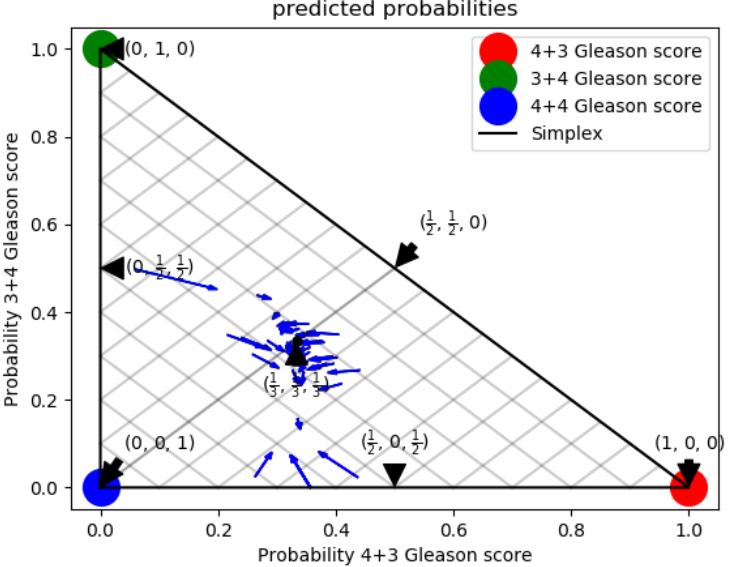
Figure 4. Uncalibrated